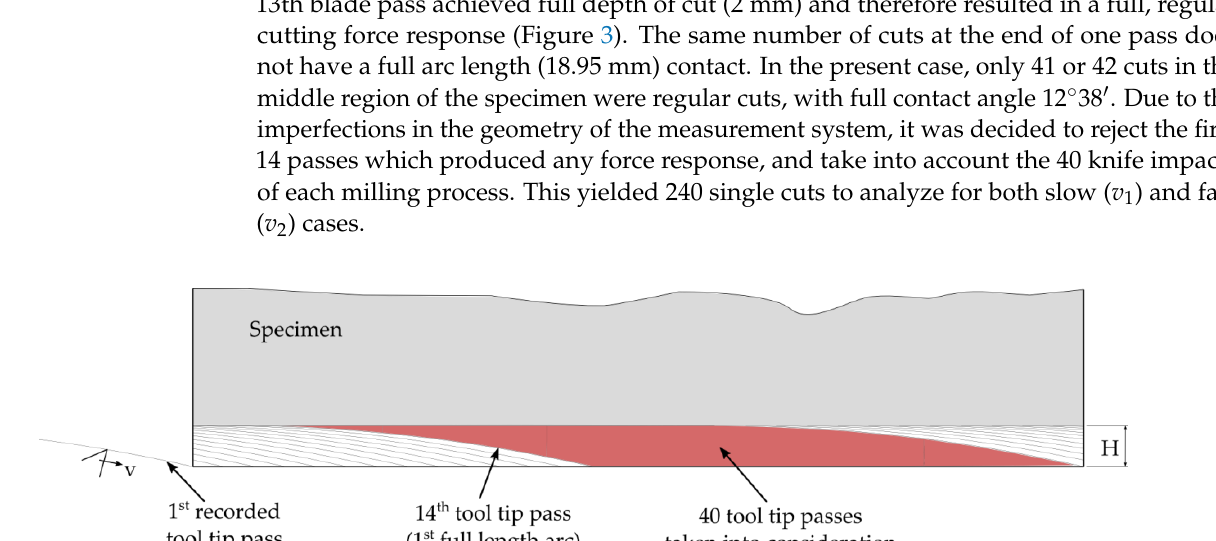
Figure 3. Subsequent tool tip passes in the workpiece. The first 13 passes at the beginning of machining were omitted from analysis, and the next 40 single full arc length cuttings were taken into consideration for force analysis (red color).